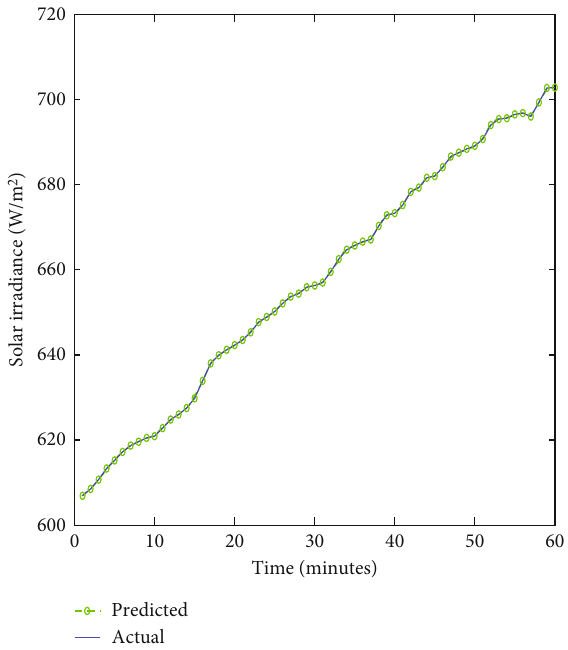
Figure 4: Comparison of predicted solar irradiance and actual solar irradiance for sunny day one-hour-ahead prediction.